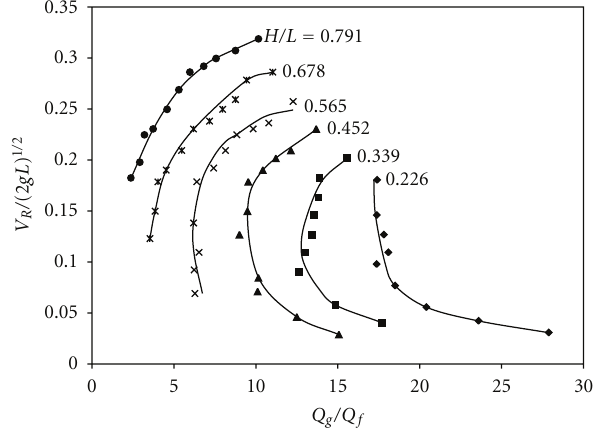
(cid:6) 2 gL with Q g /Q f at various submergence